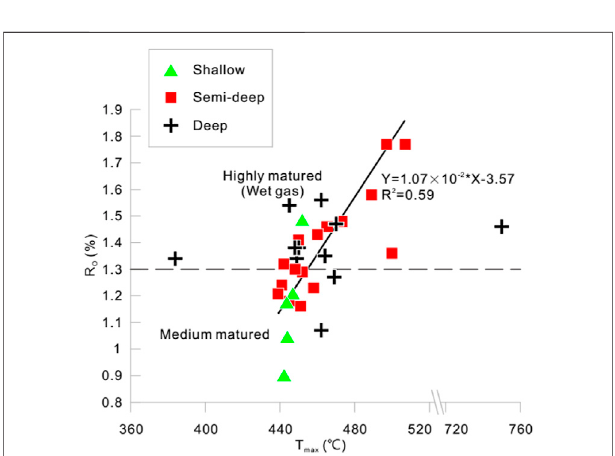
FIGURE 9 | Trends between the vitrinite re fl ectance (R o ) and T max of black shale of the Dongyuemiao member.